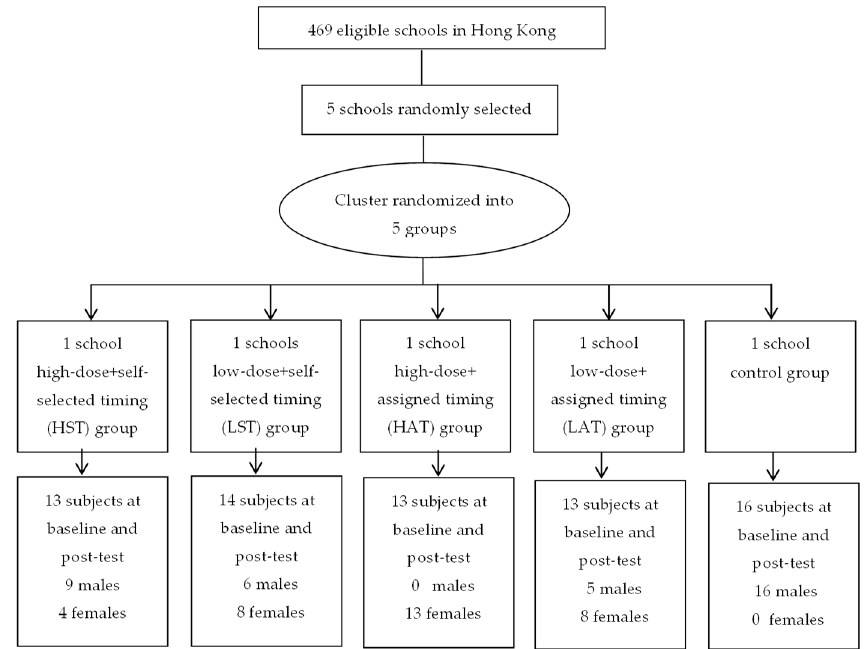
Figure 1. A CONSORT statement of participants’ flow.